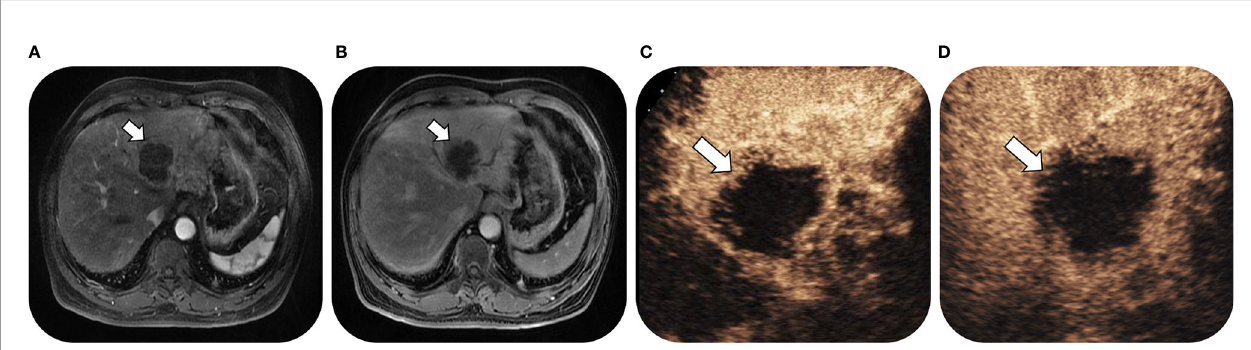
FIGURE 2 | Images in a 63-year-old man with chronic hepatitis B virus infection and pathological con fi rmed intrahepatic cholangiocarcinoma lesion, which was correctly classi fi ed as LR-M both on CEUS and gadopentetate-enhanced MRI. T1-weighted image shows a 58-mm nodule in hepatic segment II/III/IV with rim arterial phase hyperenhancement (arrow) in (A) arterial phase followed by delayed central enhancement (arrow) in (B) portal phase. Contrast-enhanced US image shows a 68-mm nodule with rim arterial phase hyper-enhancement (arrow) in (C) arterial phase (timer, 00:22) followed by marked washout (arrow) visible in (D) portal phase (timer,